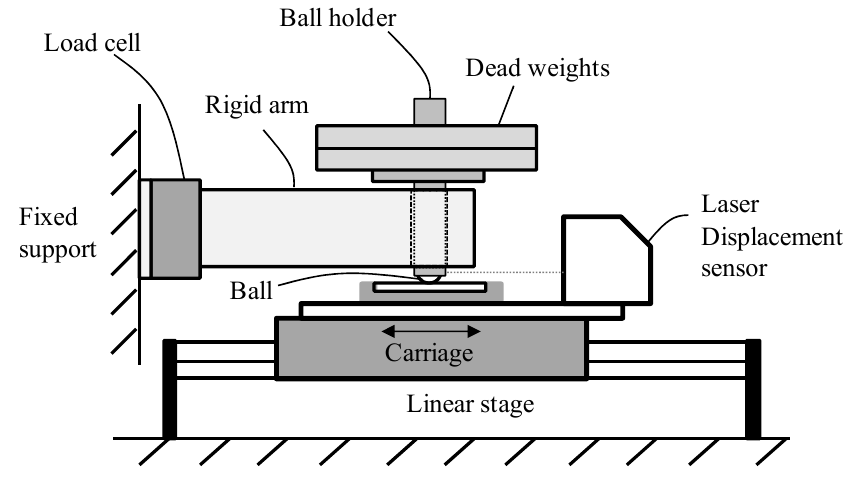
Figure 1. Schematic illustration of the apparatus for fretting testing.